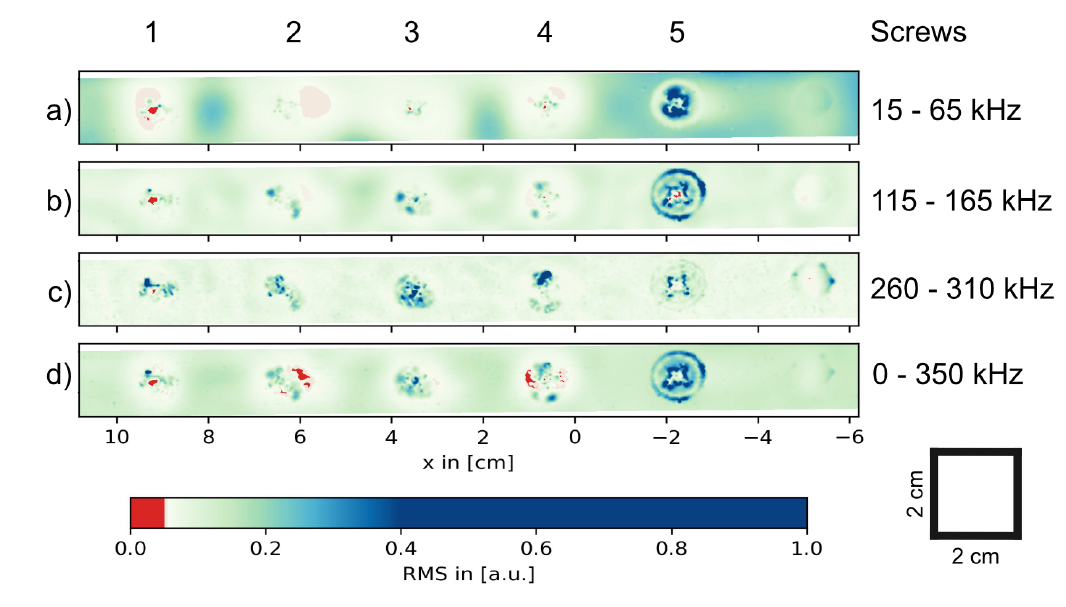
Figure 8. The band pass filtered and normalized RMS heat map for different frequencies ( a – d ) for area I of the fuselage panel. The color bar at the bottom refers only to ( d ) as it is adapted for each filter according to the description above.